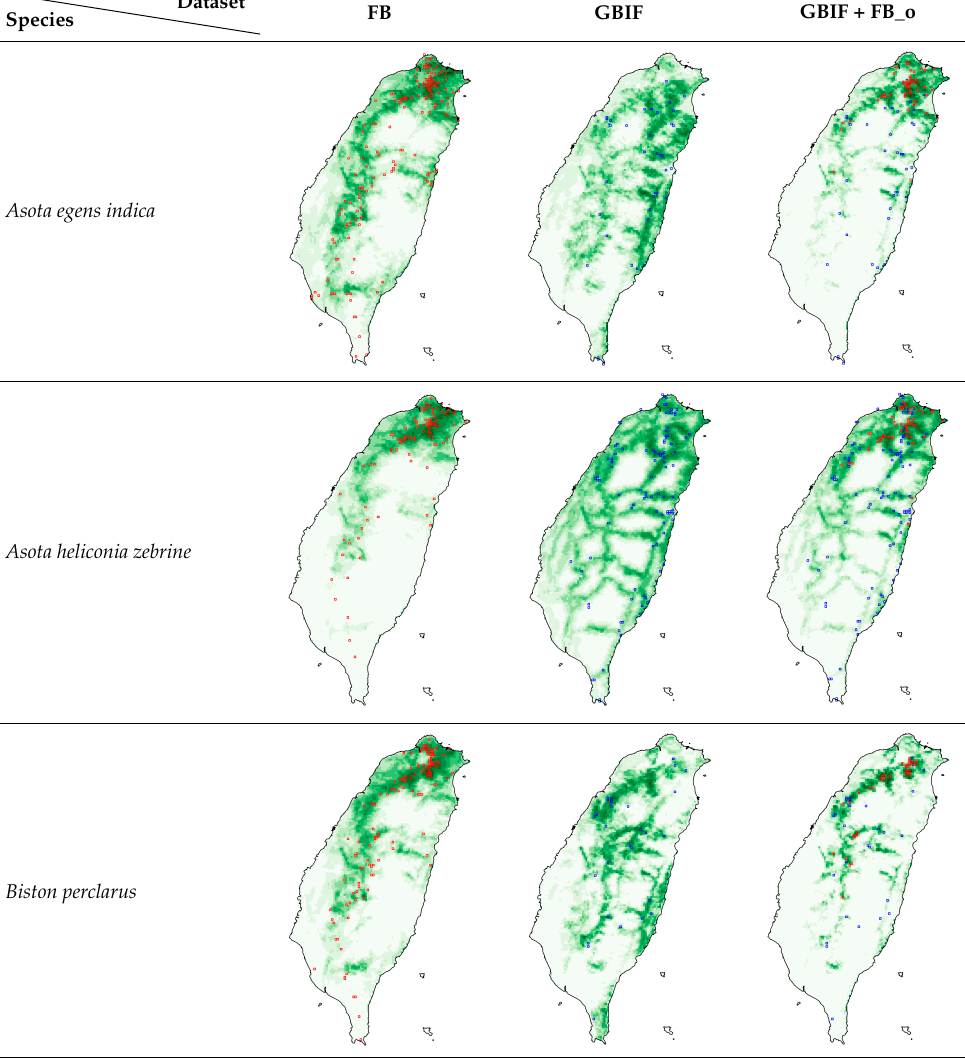
Table 2. Observed species locations in FB red (left), GBIF blue (center), and GBIF + FB_o red/blue (right); and habitat suitability distributions based on the above-mentioned datasets for each species.